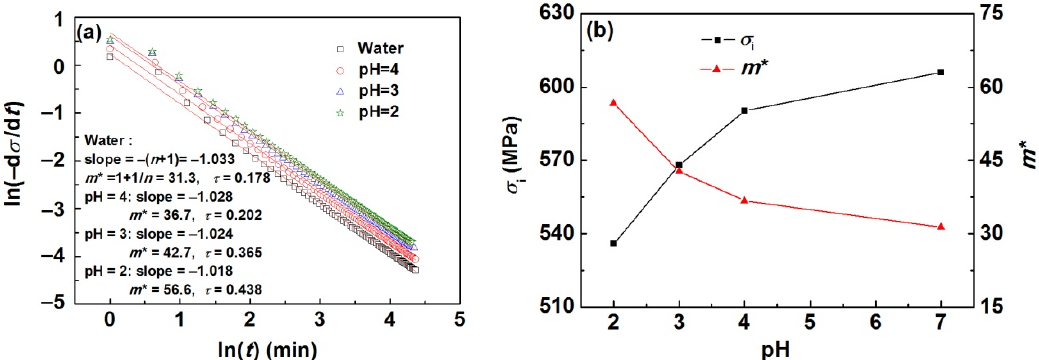
. Figure 4. ( a ) Log-log plot of 𝜎(cid:4662) vs. t in water and H 2 SO 4 solutions with various pH values, ( b ) var- Figure 4. ( a ) Log-log plot of σ vs. t in water and H 2 SO 4 solutions with various pH values, iations of σ i and m * with pH values. ( b ) variations of σ i and m * with pH